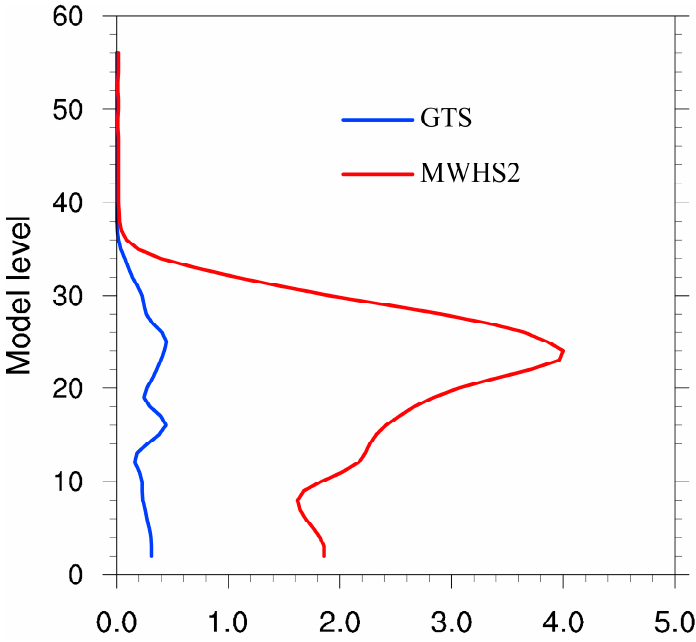
Figure 8. Vertical increment RMSE profile of specific humidity (unit: 0.1 g/kg).